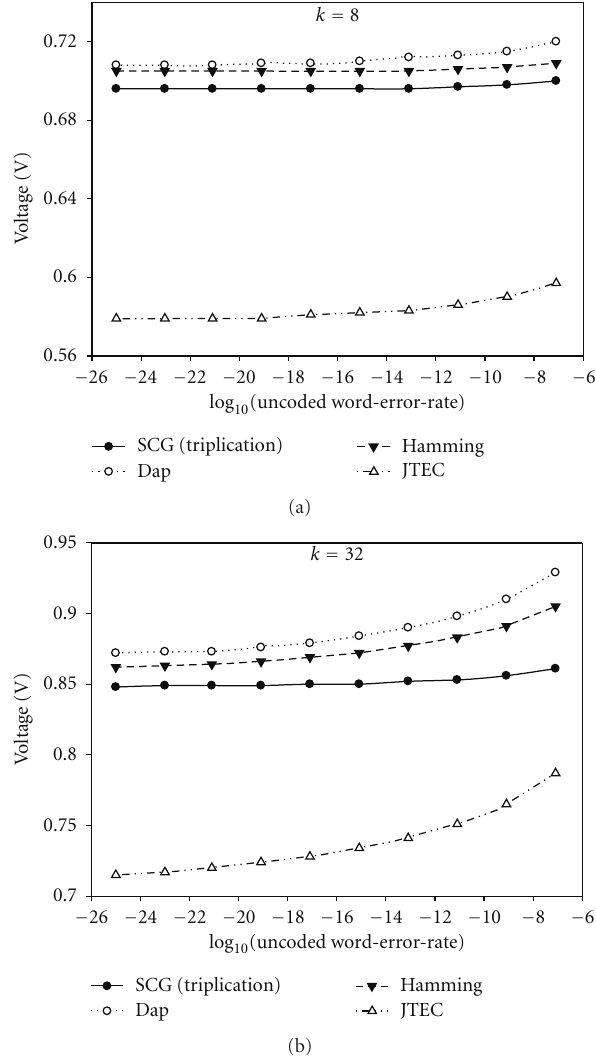
Figure 4: The corresponding voltages of specific error correction coding versus di ff erent uncoded word-error-rate with (a) k = 8 and (b) k =